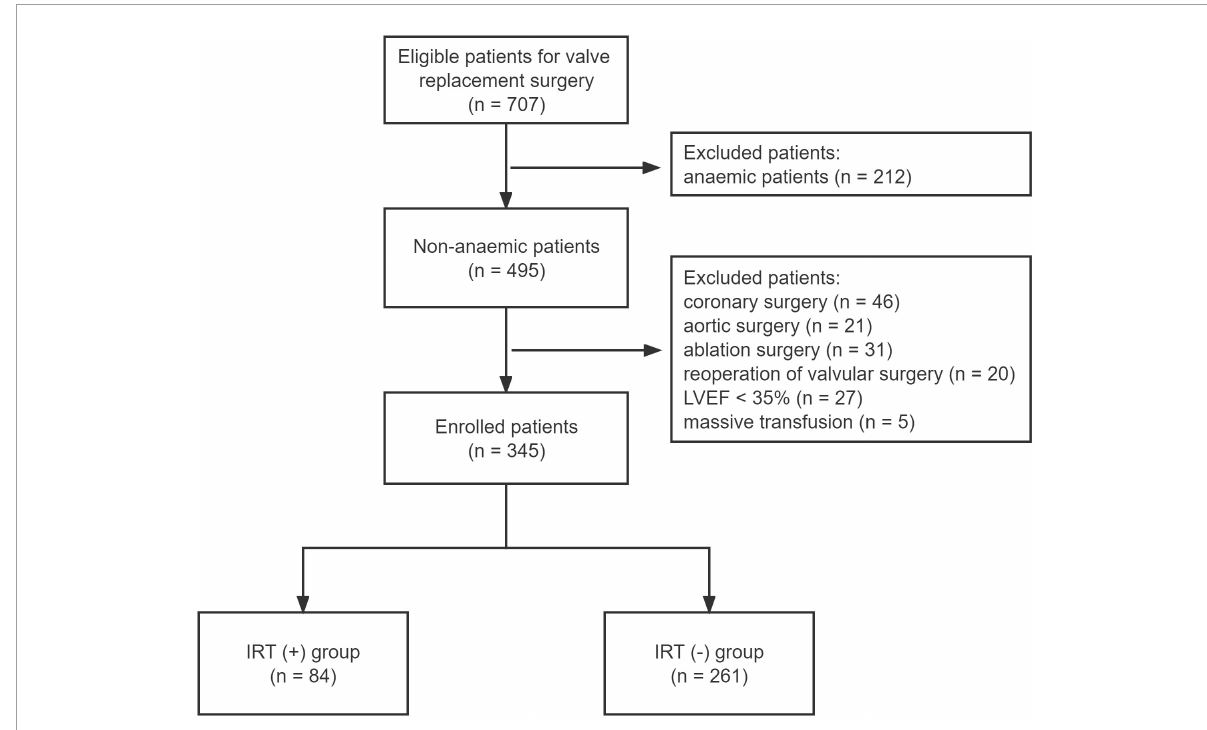
FIGURE1 Flow chart of the study enrollment. LVEF, left ventricular ejection fraction; IRT, intraoperative red blood cell